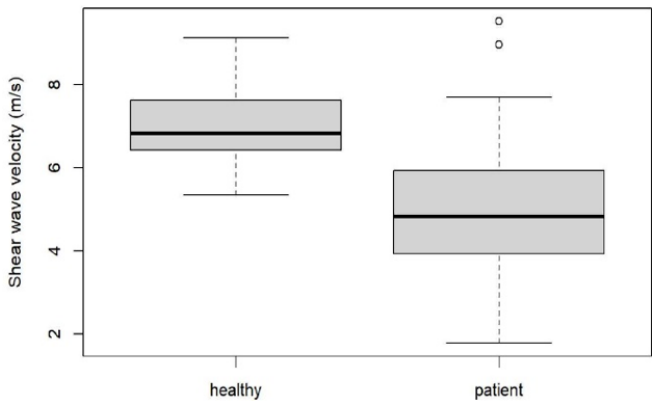
Figure 5. SWV and thickness for Patients with plantar fasciitis and Healthy volunteers, showing no correlation.